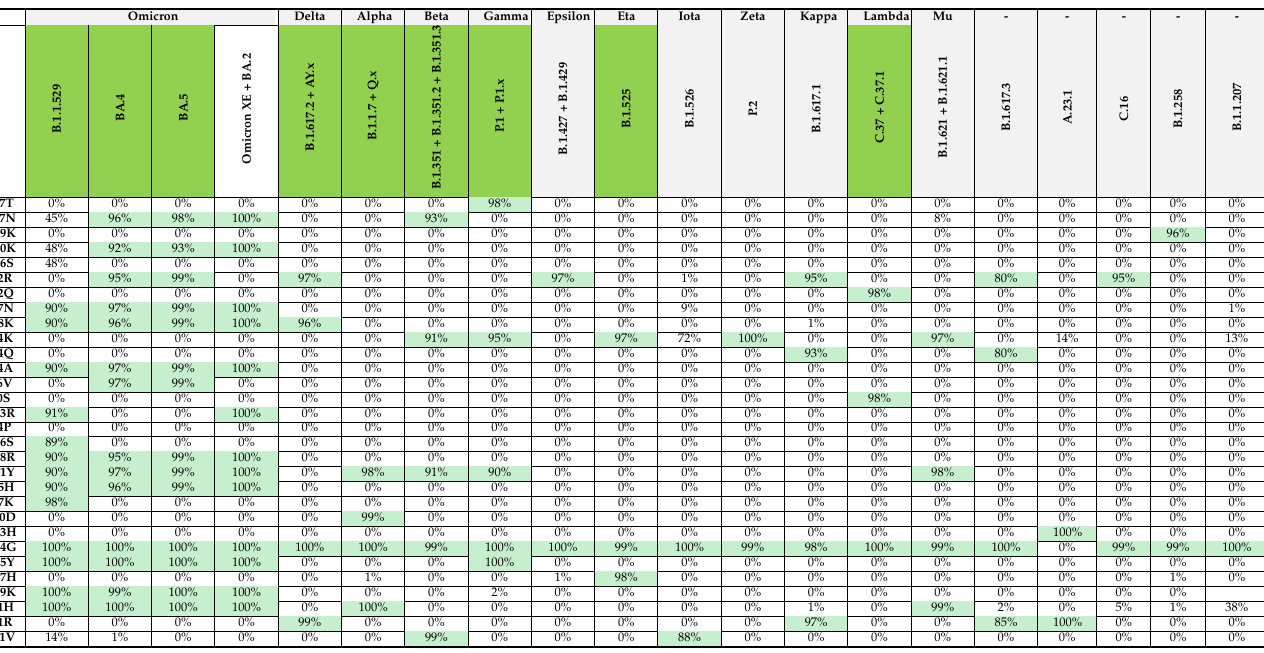
Table A1. The table shows the inclusivity for the combination of all mutations in each variant, according to data obtained from GISAID in October 2022. In green, inclusivity percentages above 80% are highlighted.